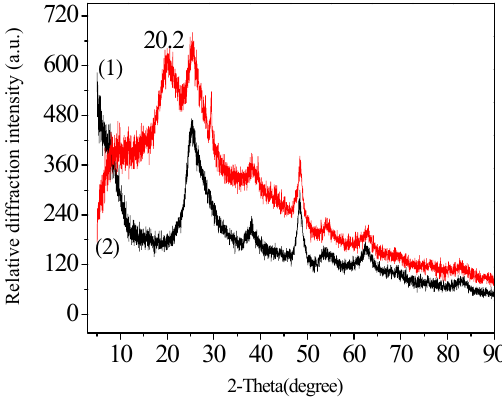
Figure 5. XRD curves of (1) MIL-125 and (2) MIL-125-CS.